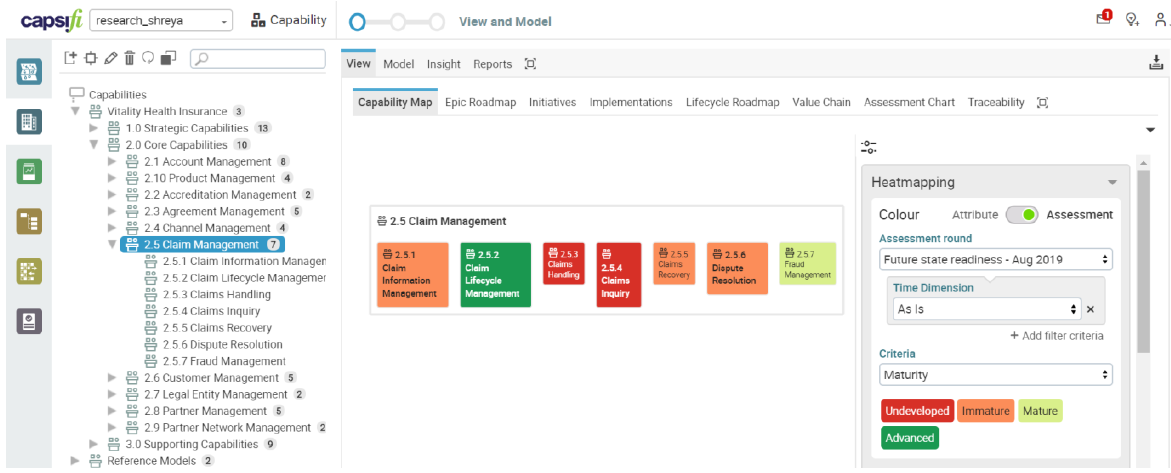
Figure 7. Capability Map with a current state assessment heatmap